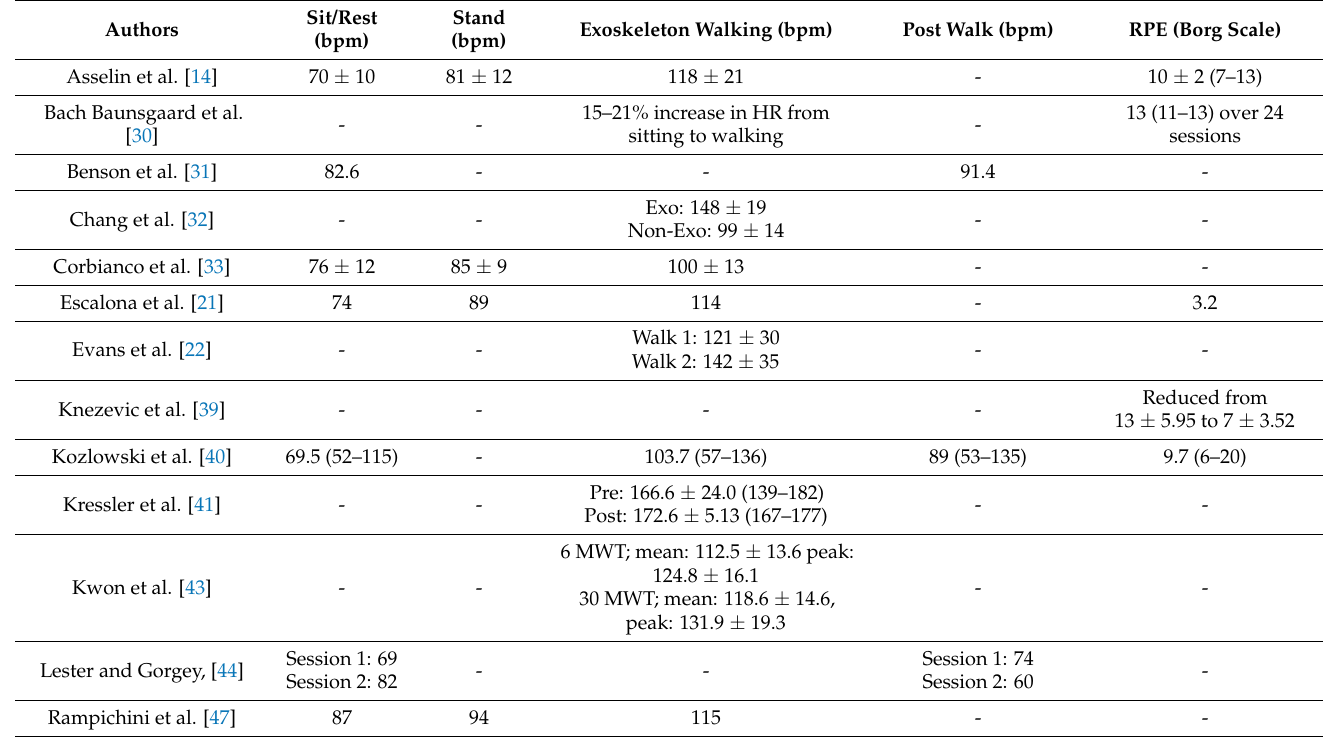
Table 3. Mean HR (bpm) and RPE (Borg scale) data of exoskeleton assisted